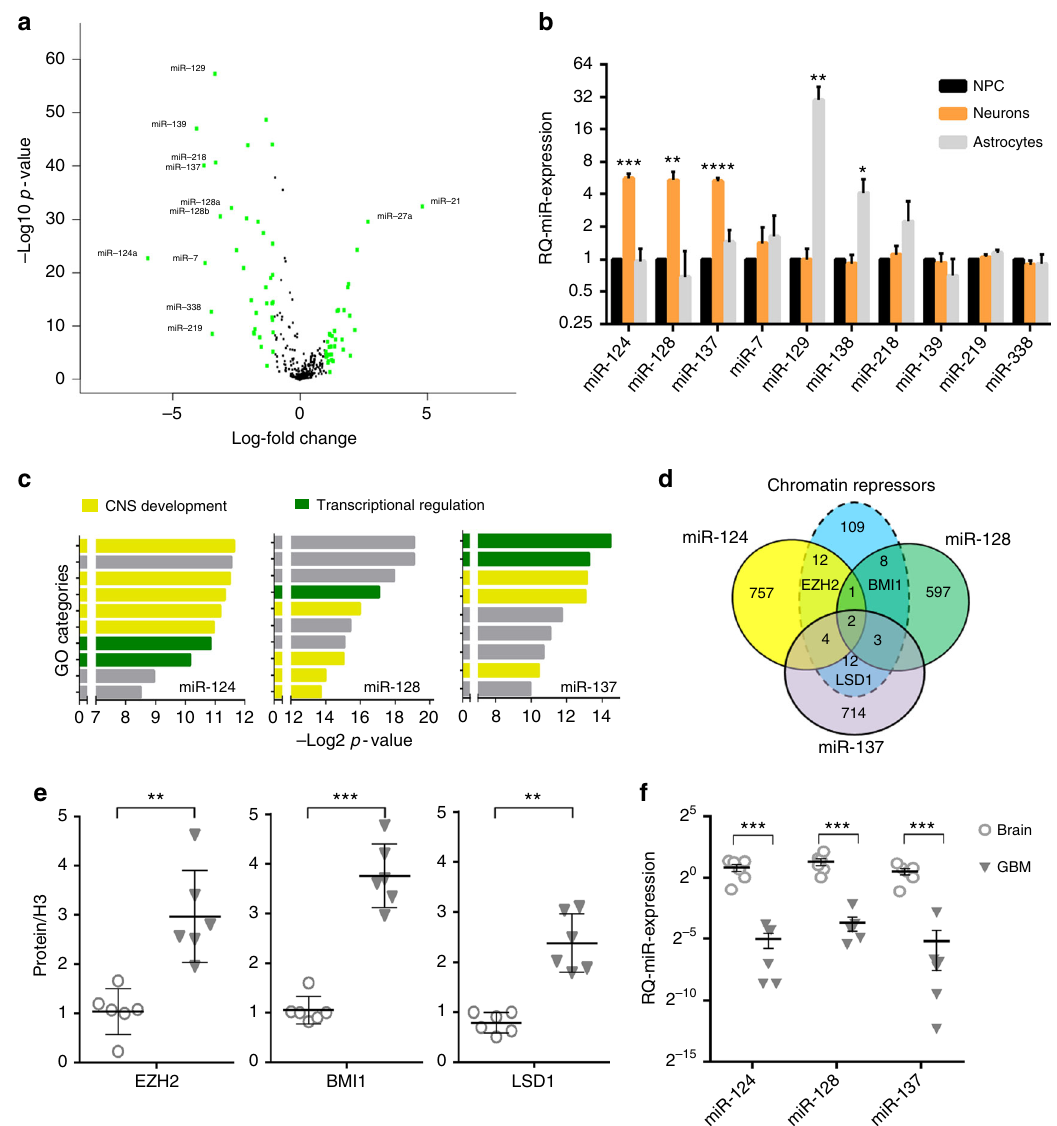
Fig. 1 A neuronal microRNA module targets multiple chromatin modifying proteins in GBM. a Volcano plot showing the most deregulated microRNAs in glioblastomas ( n = 520) vs. normal brain ( n = 10). Green color = >4-fold change in expression. b Real-time quantitative PCR analysis of microRNA expression in human neural progenitor cells (NPC) upon induction of lineage-speci fi c differentiation. Mean ± SD from three biological replicates. c Schematic representation of the ten most enriched GO categories among the predicted targets of miR-124, miR-128, and miR-137, respectively. Yellow color denotes genes with involvement in neural development. Green color denotes genes with involvement in transcriptional regulation. Gray color denotes any other biological process. d Venn diagram crossing the predicted targetome of each microRNA against the group of genes with repressive chromatin function according to GO analysis. e Semiquantitative protein quanti fi cation of western blot analysis from operatory specimen lysates. For each protein, all samples were equalized to the expression level of Normal Brain #1. f Relative quanti fi cation of microRNA expression in clinical samples of GBM and brain by real-time PCR. All samples were equalized to the expression level of Normal Brain #1.* p < 0.05; ** p < 0.01; *** p < 0.001; **** p <